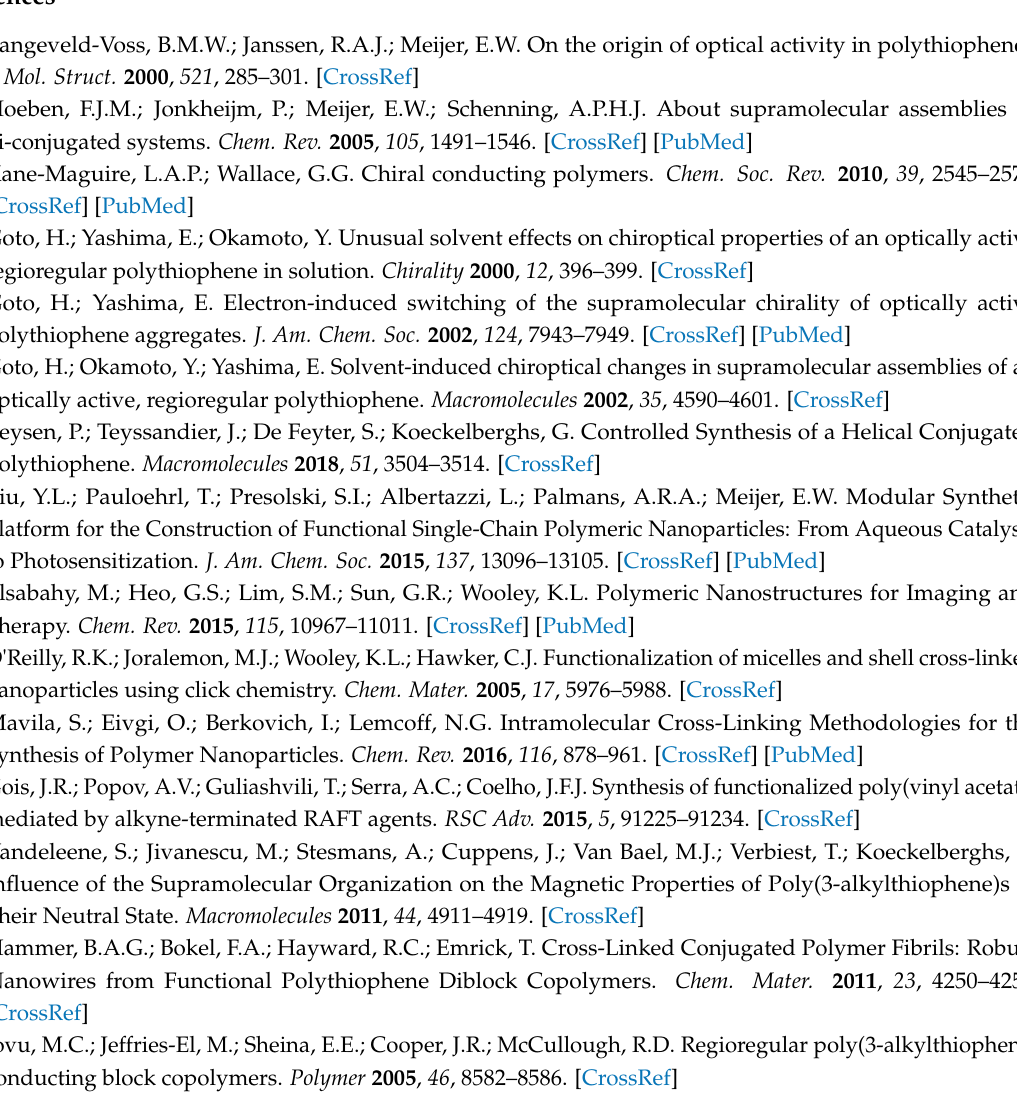
Figure S1: 1 H NMR spectrum of ( S )-poly- 1a , Figure S2: 1 H NMR spectrum of ( S )-poly- 1a -OH, Figure S3: 1 H NMR spectrum of ( S )-poly- 1a -Br, Figure S4: 1 H NMR spectrum of ( S )-poly- 1a -N 3 , Figure S5: 1 H NMR spectrum of poly- 2 , Figure S6: 1 H NMR spectrum of ( S )-poly- 1a - b -poly- 3 , Figure S7: 1 H NMR spectrum of poly- 1b - b -poly- 2 , Figure S8: 1 H NMR spectrum of poly- 1b - b -poly- 3 , Figure S9: DLS data of the micelles comprising ( S )-poly- 1a - b -poly- 3 , Figure S10: Time-dependent CD intensity change of ( S )-poly- 1a in CHCl 3 /MeOH (1/1, v / v